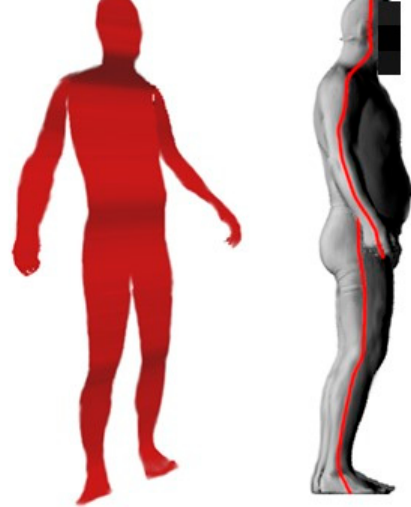
Figure 8. Generated mid-surface projection after smoothing process.